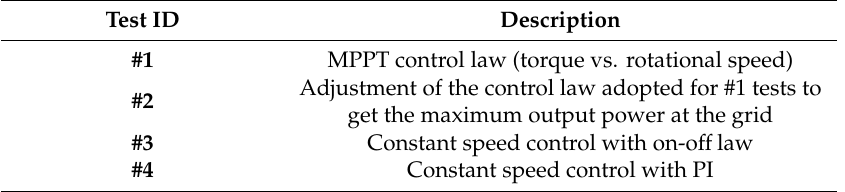
Table 2. Test plan applying di ff erent control laws with the Impulse